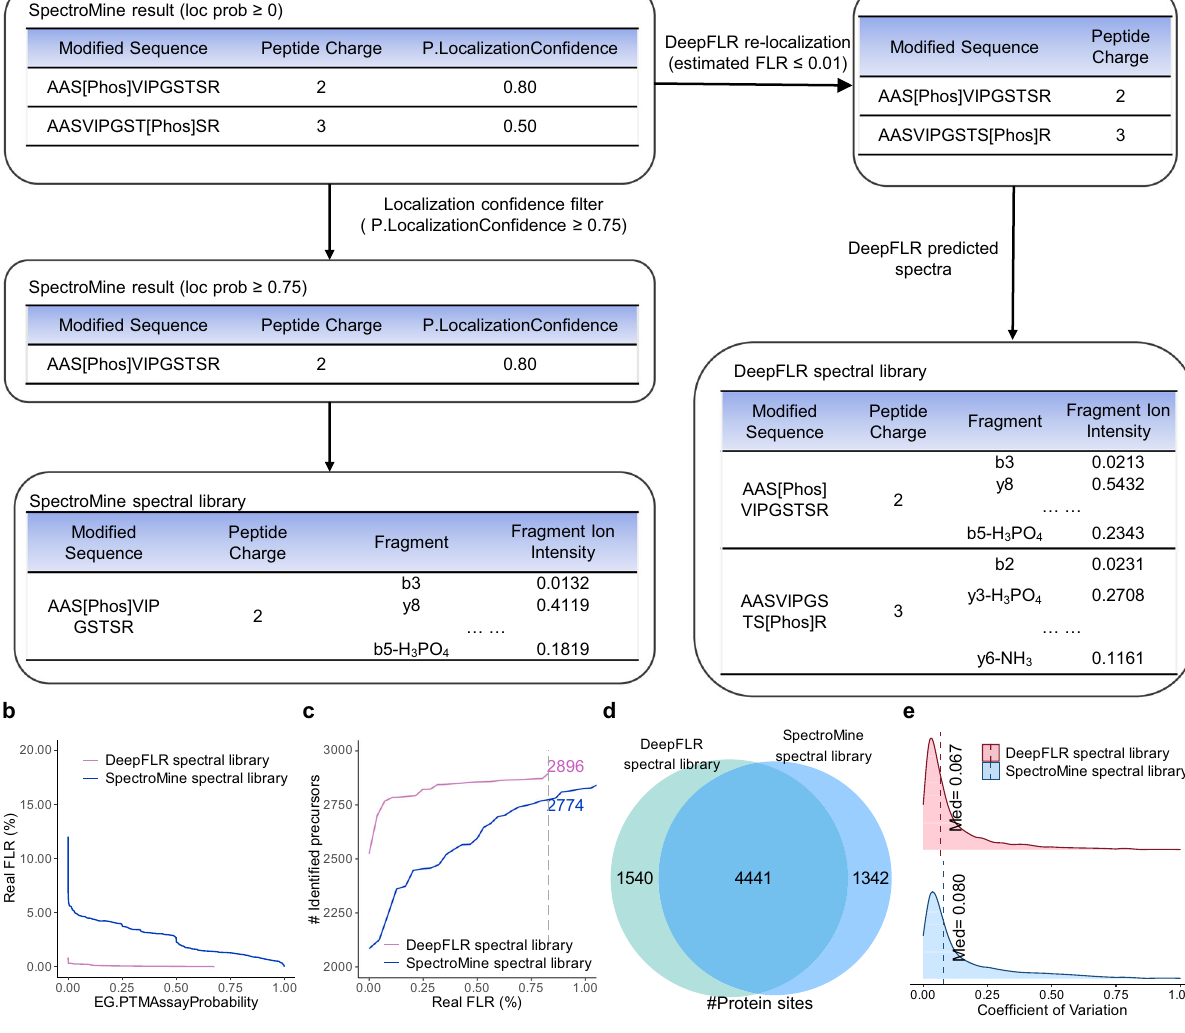
precursors. d Venn diagram of the number of phosphosites localized for a biolo- gicalphosphopeptidesdataset DIA_2usingDeepFLR predicted spectrallibraryand SpectroMine-based experimental spectral library. e Coef fi cient of variation calcu- latedbased on theproteinphosphositesquantityamongthreetechnicalreplicates in DIA_2 using DeepFLR predicted spectral library and SpectroMine-based experi- mental spectral library. Source data are provided as a Source Data fi